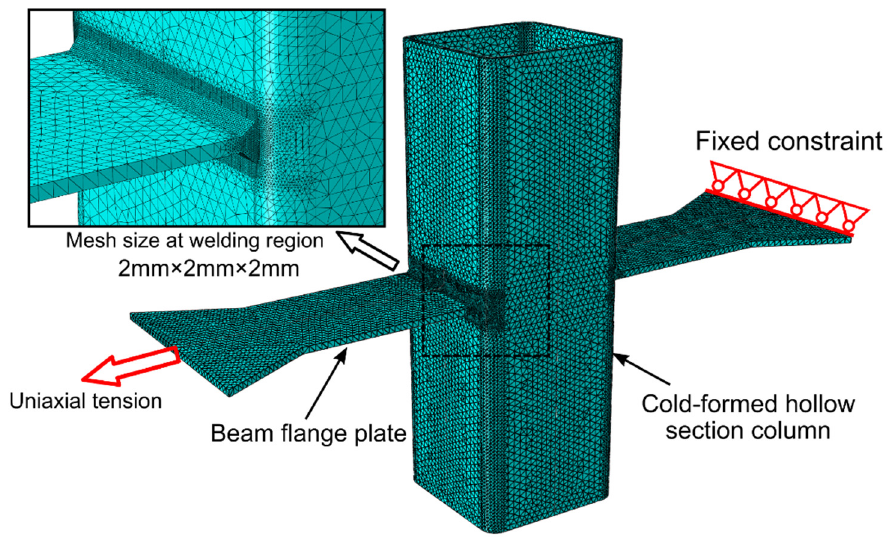
Figure 7. Finite element of the RP-1 specimen.